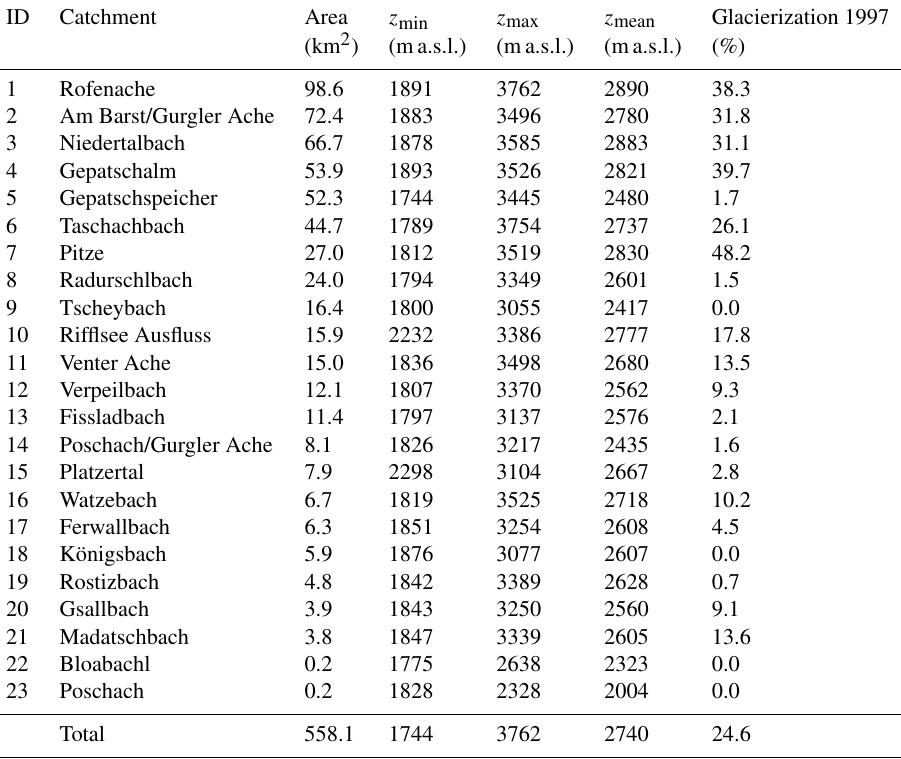
Table 1. Area, minimum/maximum/mean elevation, and glacierization (as of the year 1997) of the investigated catchments. The catchment IDs correspond to the labels in Fig.